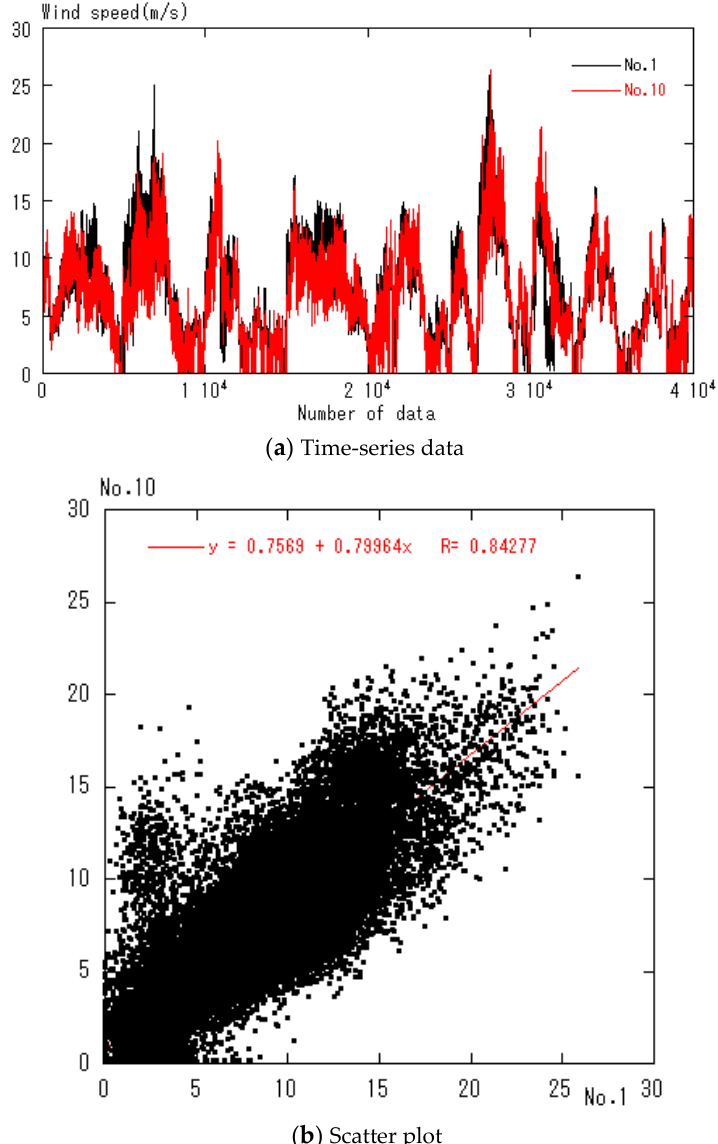
Figure 13. Comparison of hub-height wind speed at WT #1 and WT #10, observation data.